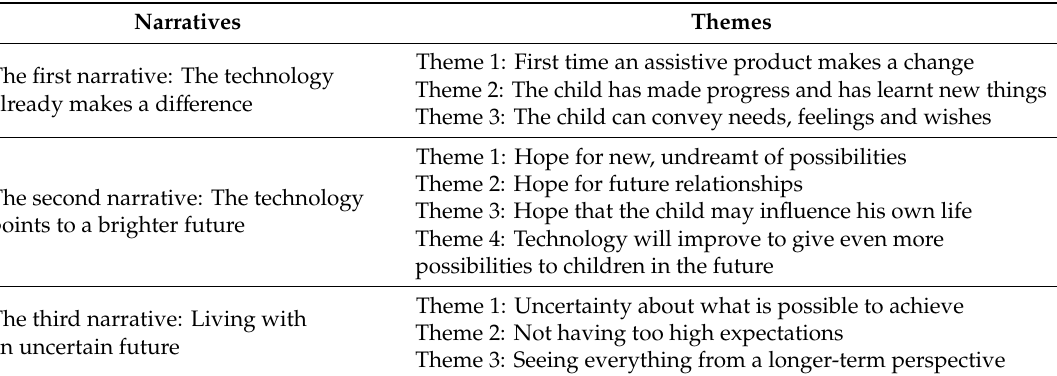
Table 1. Narratives and themes.